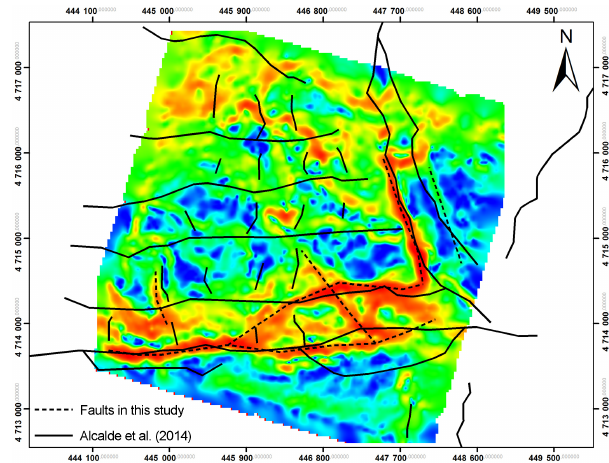
Figure 9. THD map of the gravity residual depicted in Fig. 7d with a comparison between the faults interpreted from this map and the gravity inversion (discontinuous line) and those interpreted by Al- calde et al. (2014) from 3-D